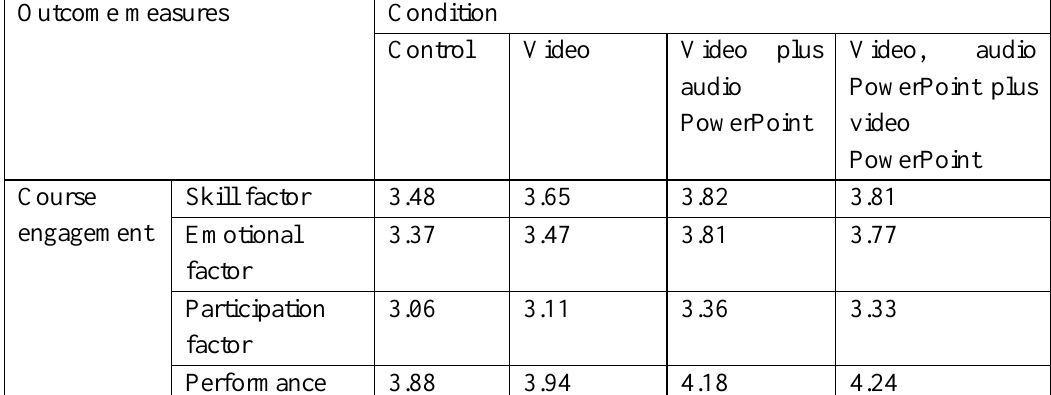
Table 4 Mean Scores by Multimedia Condition Outcome measures